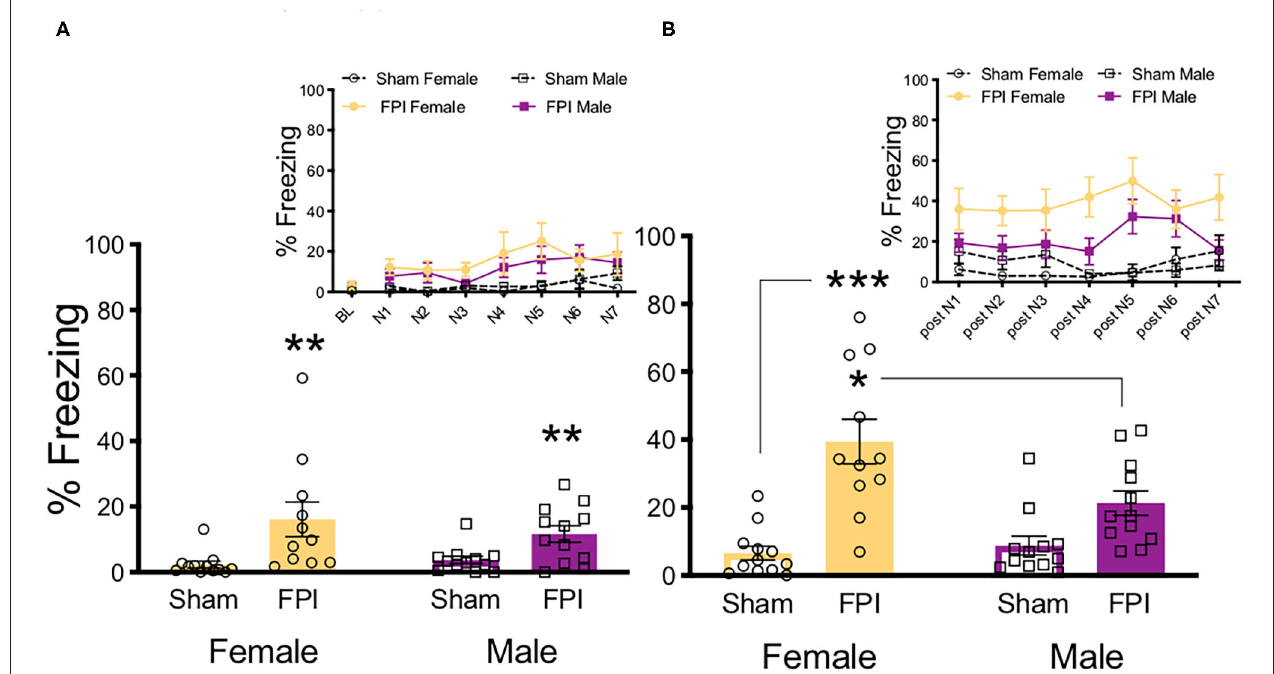
FIGURE 2 | Females exhibit more phonophobia following FPI. (A) Average freezing across trials of 30s/75 dB white noise pre-exposure. Inset depicts freezing across 7 white noise trials. FPI increased freezing during white noise trials, regardless of sex; ** p = 0.001. (B) Average freezing during 30s post noise interval, inset depicts freezing during inter trial intervals. FPI females displayed the highest magnitude off fear following noise termination, compared to Female Sham *** p < 0.001, and even FPI Male * p = 0.021. Data are represented as mean ± SEM; n = 11–12/group.